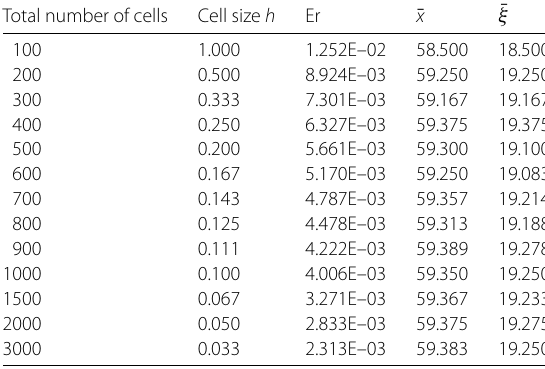
¯ ξ by the finite difference scheme are ¯ ξ = 19.262